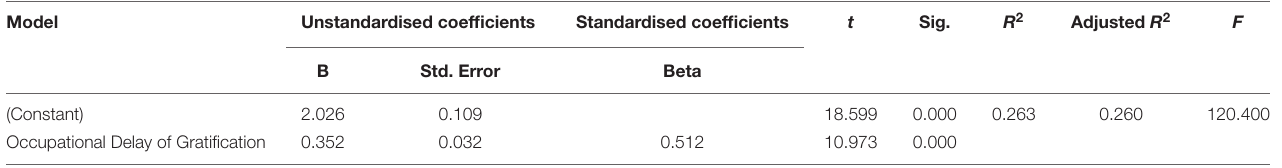
TABLE 11 | Analysis of the influence of occupational delay of gratification on PC.